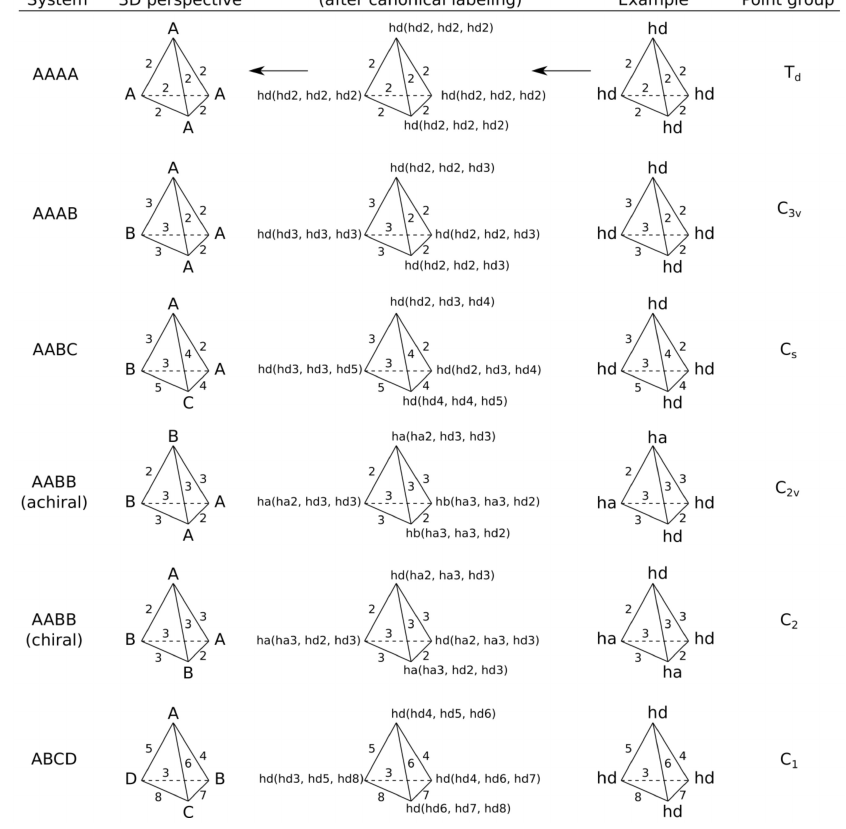
Figure 2. Basic chirality systems. Labels A, B, C and D designate distinct canonical feature labels. Labels “ha” and “hd” designate hydrogen-bond acceptor and donor features, correspondingly. Numbers on edges designate binned distances between